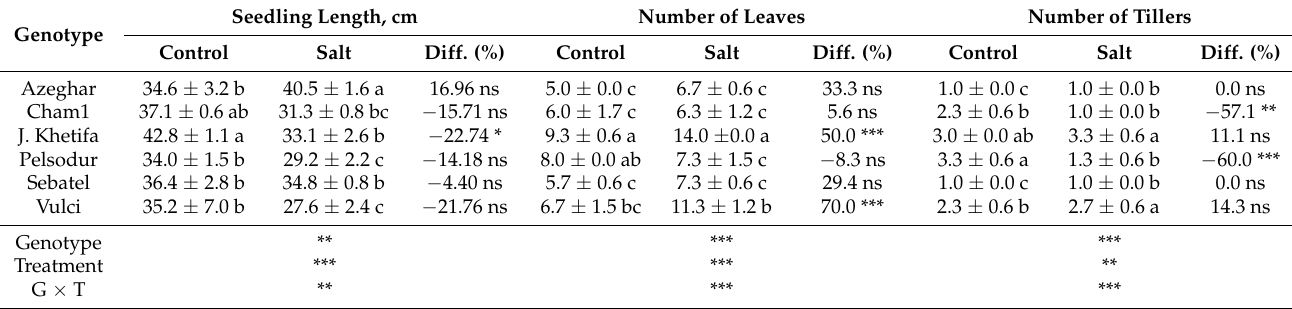
Table 1. Salt versus control effect on shoot traits of six durum wheat genotypes.